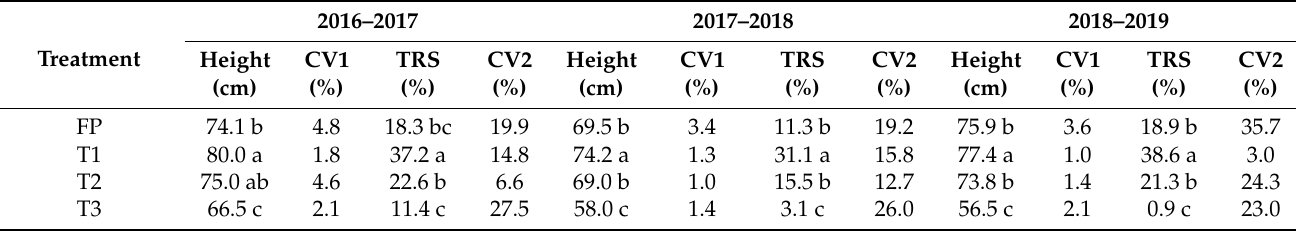
Table 4. Plant height and tillers rate per stem (TRS) and respective coefficient of variation (CV) at maturity under different treatments in the 2016–2019 growing seasons of winter wheat.